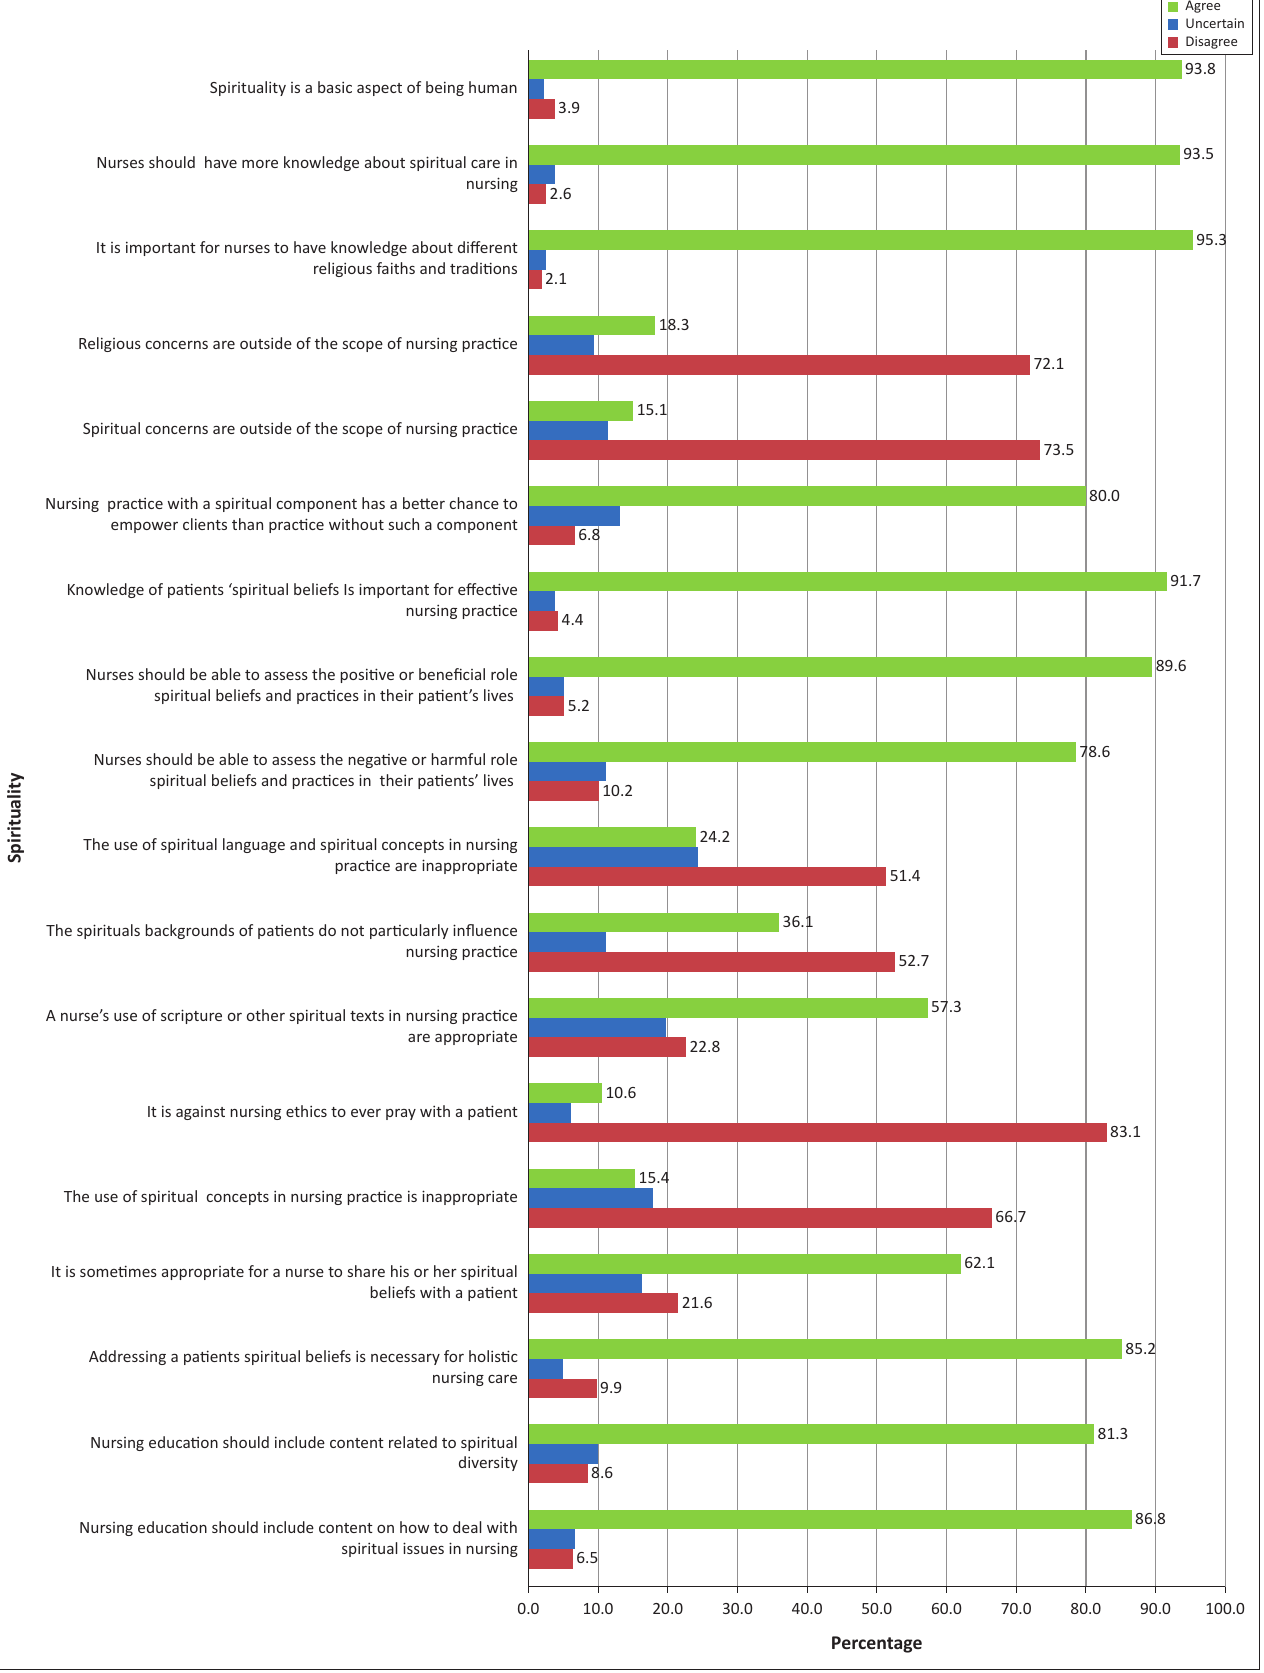
FIGURE 1: The role of spirituality in nursing